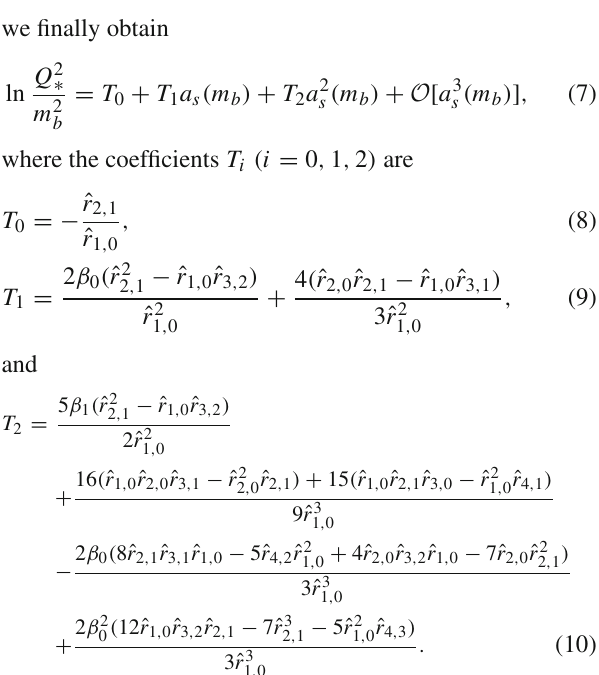
Fig. 1 The ϒ( 1 S ) leptonic decay width (cid:3) n up to n th -order QCD cor- rections as a function of the renormalization scale μ r under the conven- tional sale-setting, where n = ( 0 , 1 , 2 , 3 )